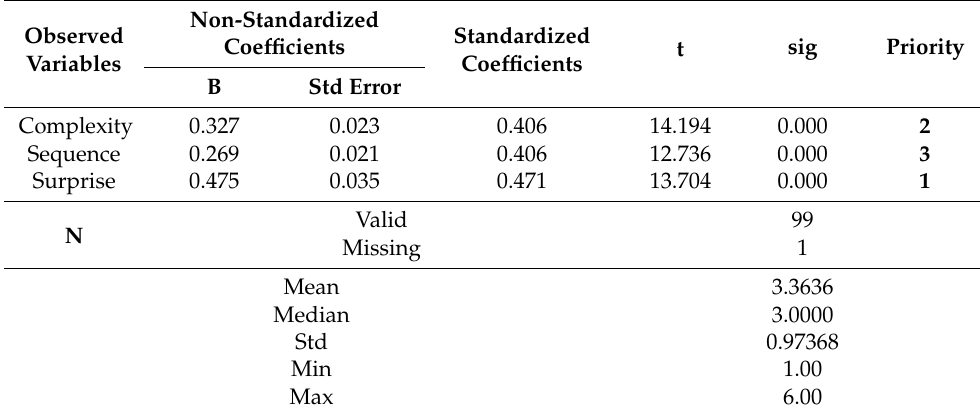
Table 6. Frequency distribution of cognitive